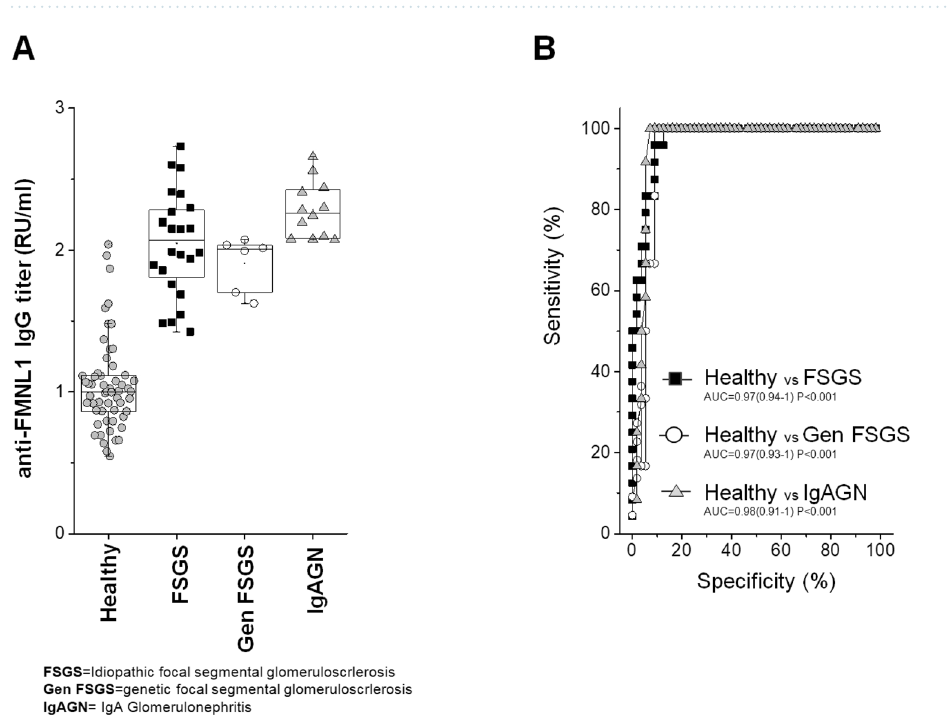
Figure 4. ELISA assay for anti-FMNL1serum levels in other glomerulonephritis. ( A ) The same ELISA modified for detection of total IgGs was utilized to test serum levels of anti-FMNL1 antibodies in patients affected by other hystologic and genetic forms of glomerulonephritis: 23 with idiopathic FSGS, 6 with genetic FSGS and12 with IgA glomerulonephritis. Anti-FMNL1 levels were statistically significant more abundant in all these groups compared with normal subjects ( P < 0.0001). ( B ) ROC curve analysis for anti-FMNL1IgGs in comparison with normal